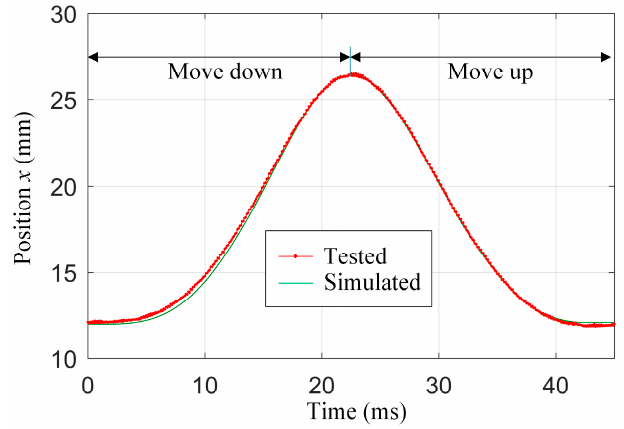
Figure 8. Comparison of tested and simulated movement.